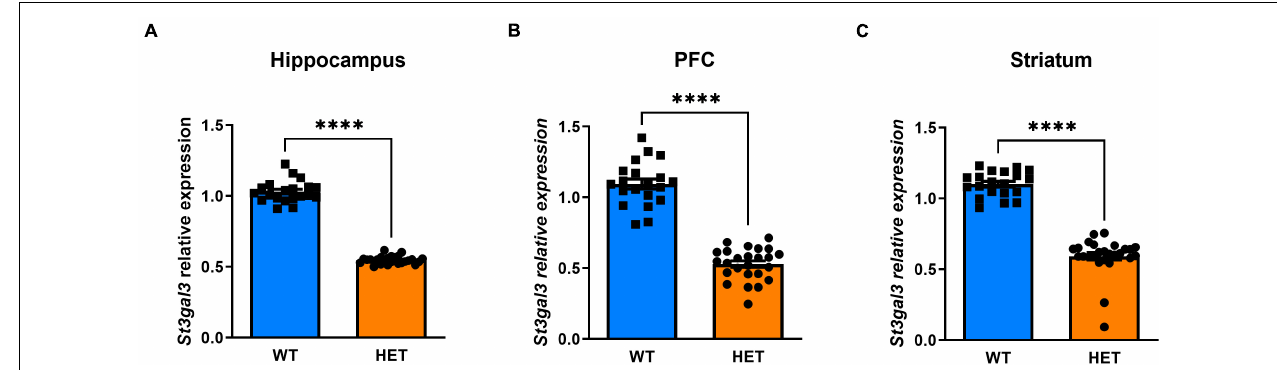
FIGURE 2 | Relative expression of St3gal3 in hippocampus, PFC and striatum of HET and WT mice. (A) Relative levels of St3gal3 mRNA in the hippocampus (HET: n = 21, WT: n = 13). (B) Levels of St3gal3 mRNA expression in the PFC (HET: n = 19, WT: n = 14). (C) Levels of St3gal3 mRNA expression in the striatum (HET: n = 20, WT: n = 14). In all analyzed brain regions, a strongly significant decrease of around 50% in St3gal3 expression was observed in heterozygote animals compared to their wildtype littermates (hippocampus: t = 29.59, p < 0.0001; PFC: t = 13.97, p < 0.0001; striatum: t = 14.62, p < 0.0001). Data were analyzed by Student’s t -test and presented as mean ± SEM. ∗∗∗∗ p < 0.0001. WT, wildtype; HET,